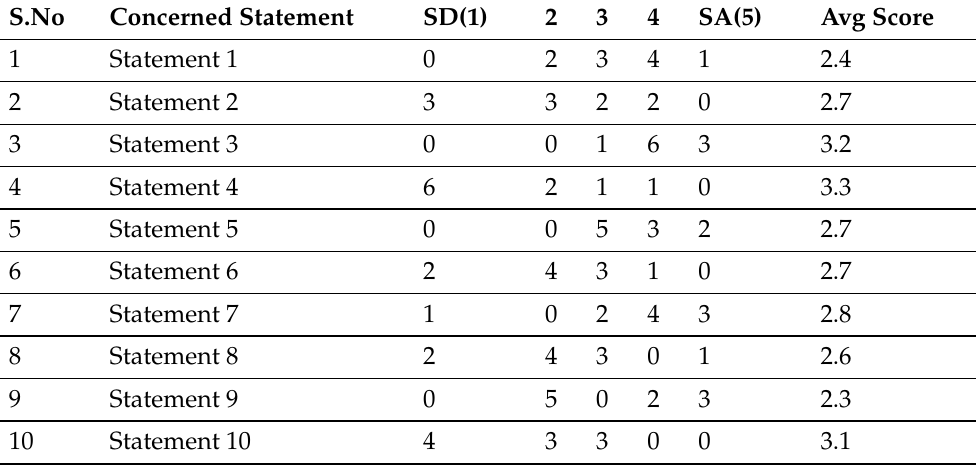
Table 4. SUS Results of G2 (Android PIN lock application Users). Average SUS Score = 27.8, Total SUS Score = 27.8 × 2.5 = 69.5.